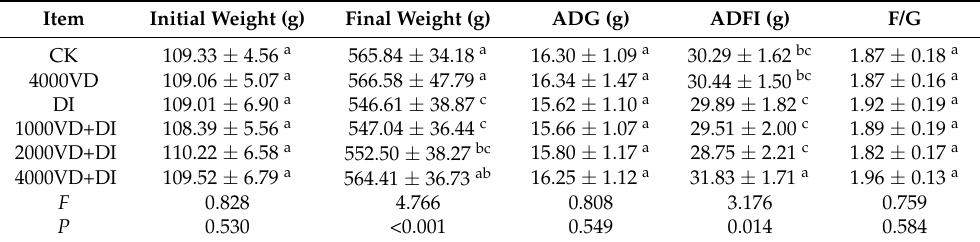
Table 2. Determination of the growth performance of the Wenchang chicken.